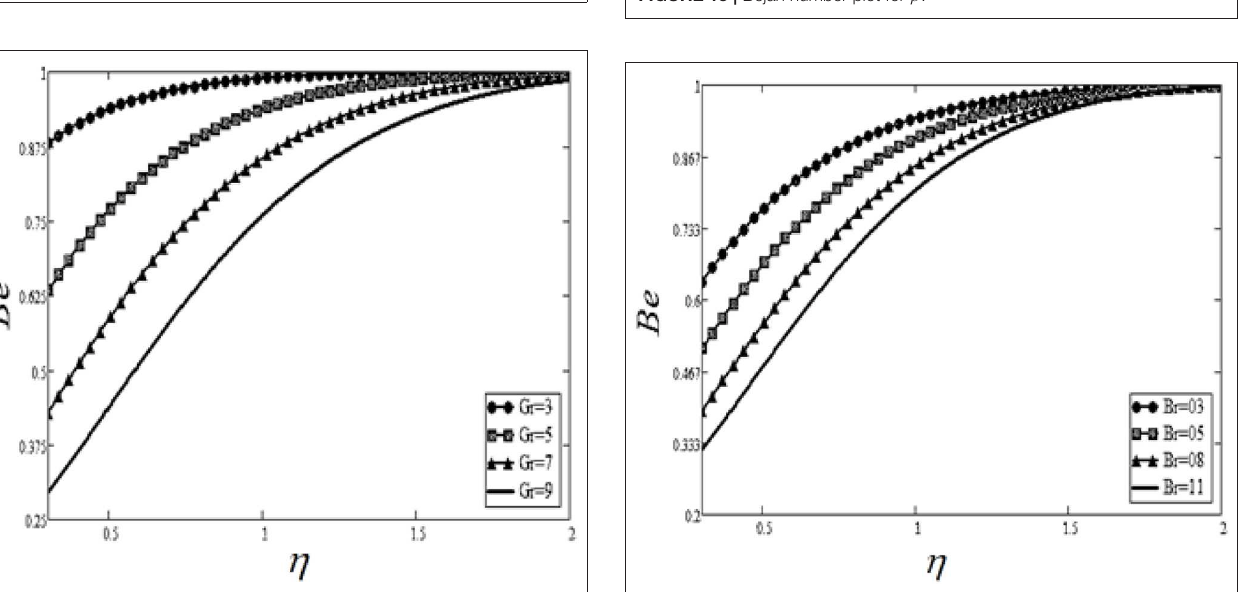
FIGURE 13 | Bejan number plot for β .